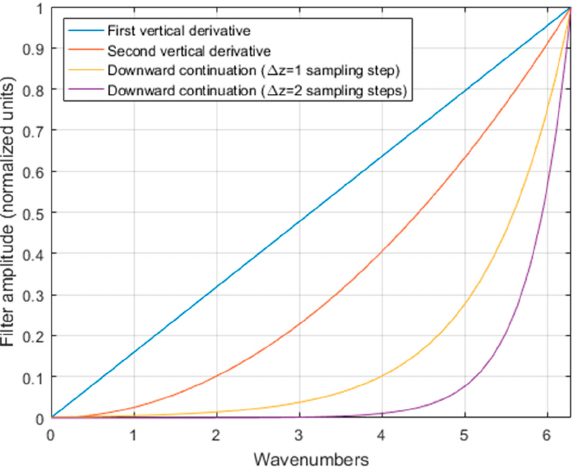
Figure 1. Wavenumber domain representation of the vertical derivative operator, for differentiation orders 1 and 2, and of the downward continuation filter, for continuation distances, ∆ z, equal to 1 and 2 times the magnetic grid sampling step.